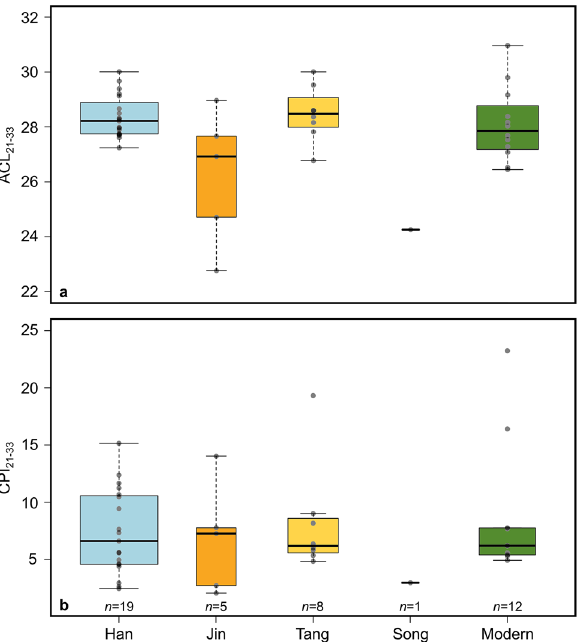
Figure 5. Box plots by age for ACL and CPI. ( a ) Average chain length of the C 21 -C 33 n -alkanes (ACL 21-33 ). ( b ) Carbon preference index of the C